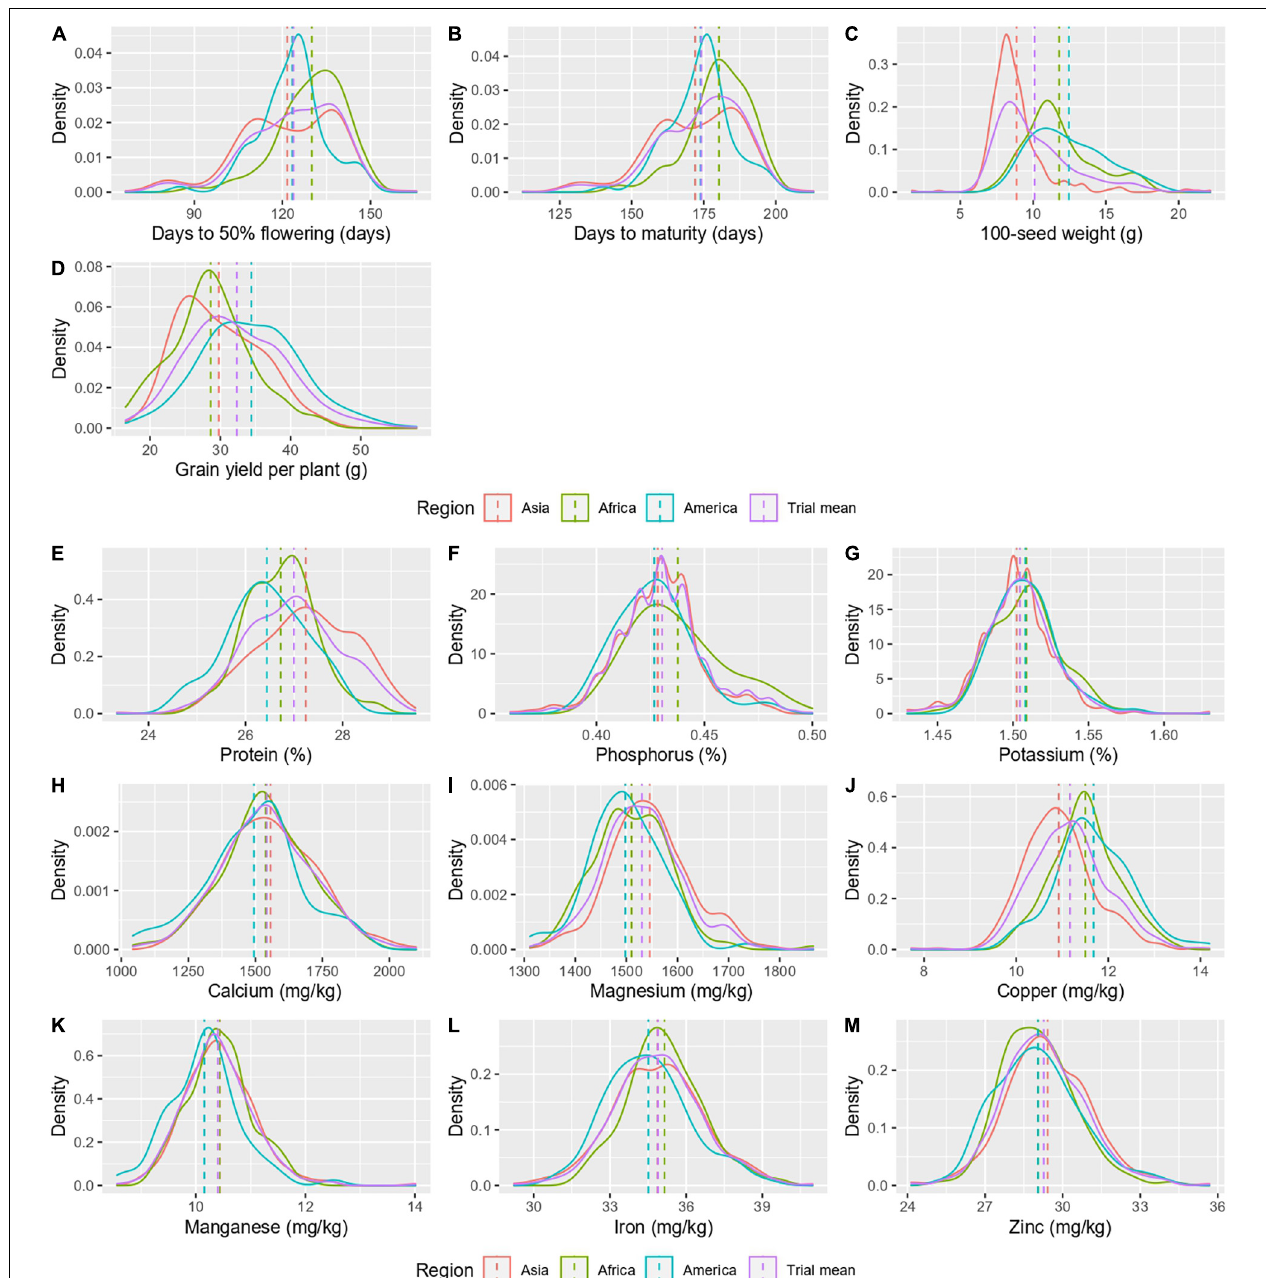
FIGURE 3 | A density graph depicting the distribution of agronomic traits (A–D) and grain nutrients (E–M) in different geographical